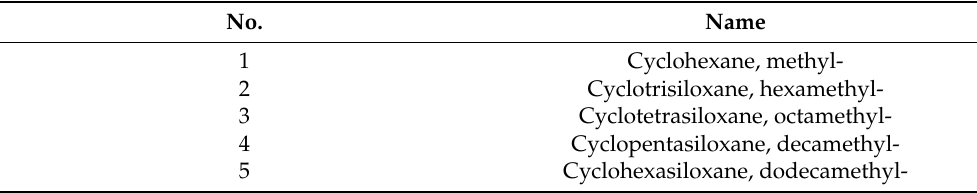
Table 3. Common pollutants in salted egg yolk flavor components.